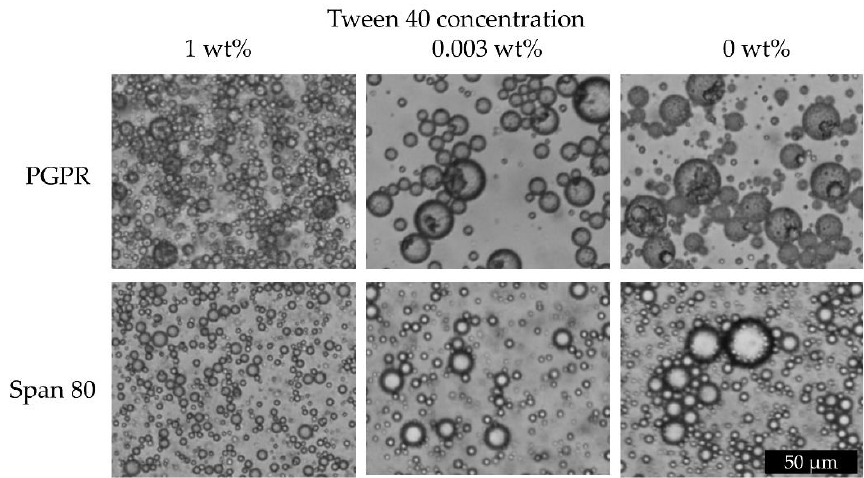
Figure 7. Micrographs of the double emulsions produced with 1 wt% PGPR or Span 80 and different Tween 40 concentrations directly after production. While the emulsions with PGPR as lipophilic surfactant showed encapsulated droplets and, therefore, a double-emulsion structure, the double emulsion with Span 80 had no inner droplets left. For both lipophilic surfactants, the oil droplet size decreased with increasing concentrations of Tween 40.